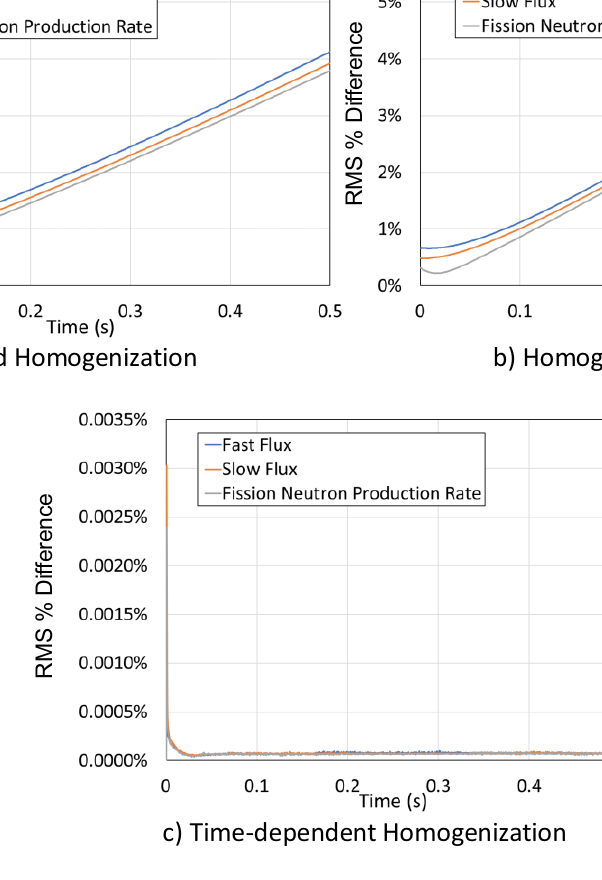
Figure 13. RMS Percent Differences between the three Homogenization Techniques and the Node- averaged Reference